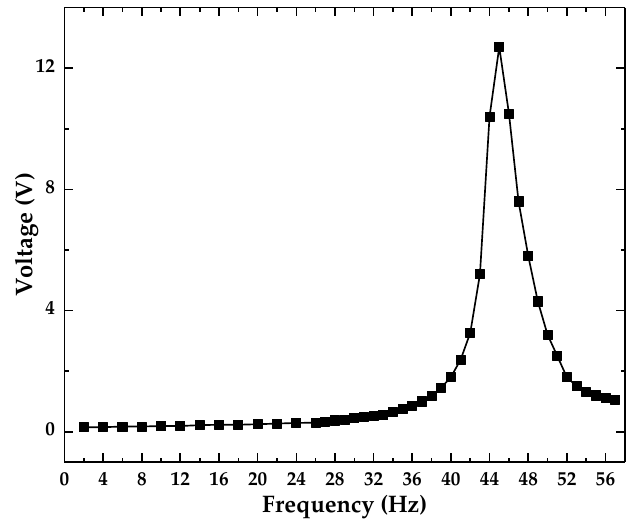
Figure 7. Frequency response test of the designed optical accelerator.